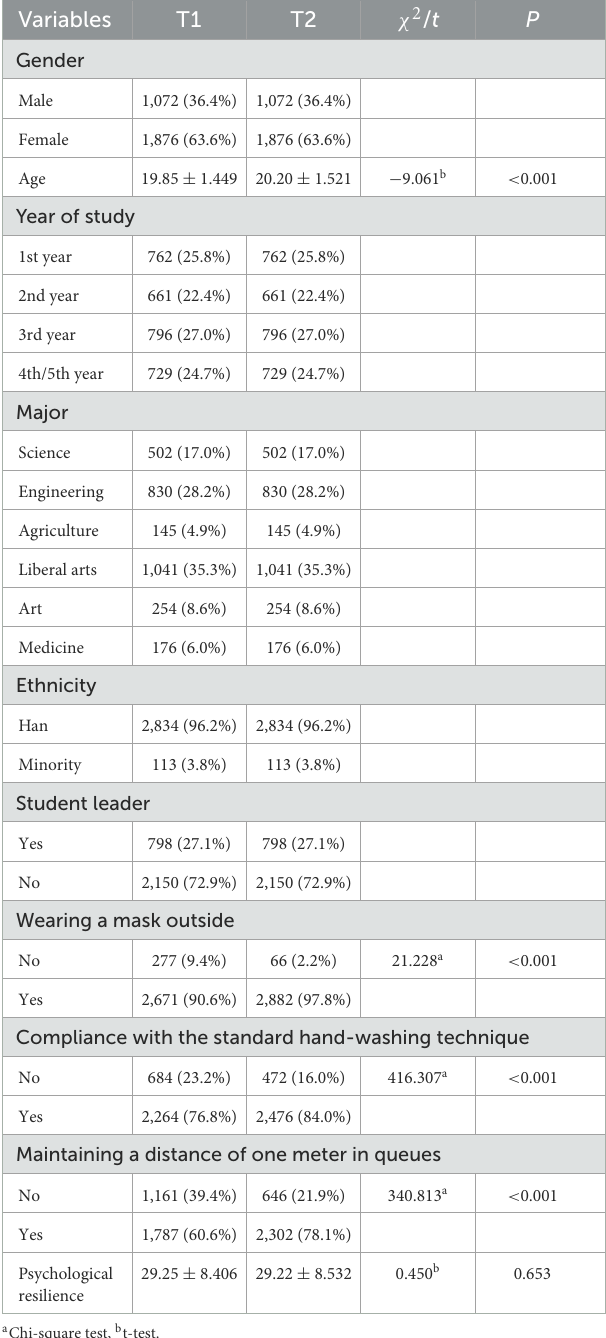
TABLE 1 Changes in COVID-19-related variables between T1 and T2. TABLE 2 Prevalence of and change in depression, anxiety, and stress at T1 and